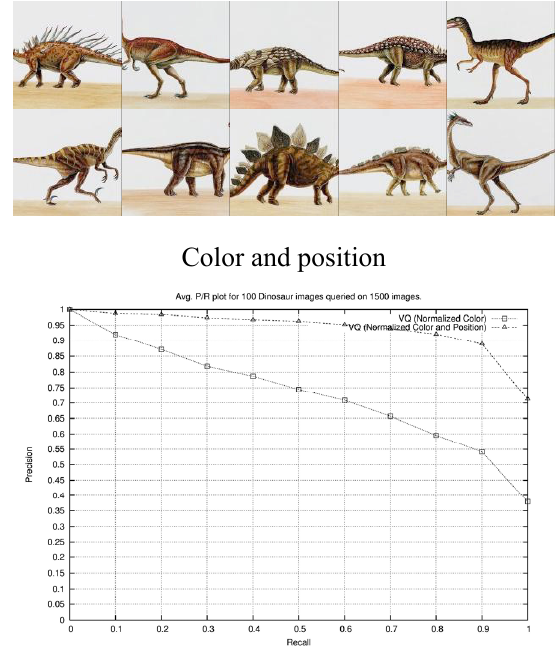
P/R for image 10588 (Dinosaur class), color vs. position